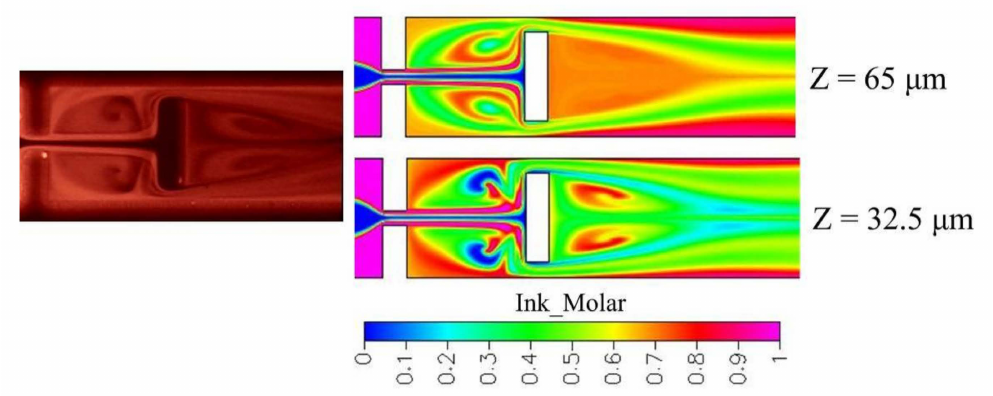
Figure 26. Mixing comparison between experiments and simulation at Re 60. Experimental top- viewing images were captured by the conventional fluorescence